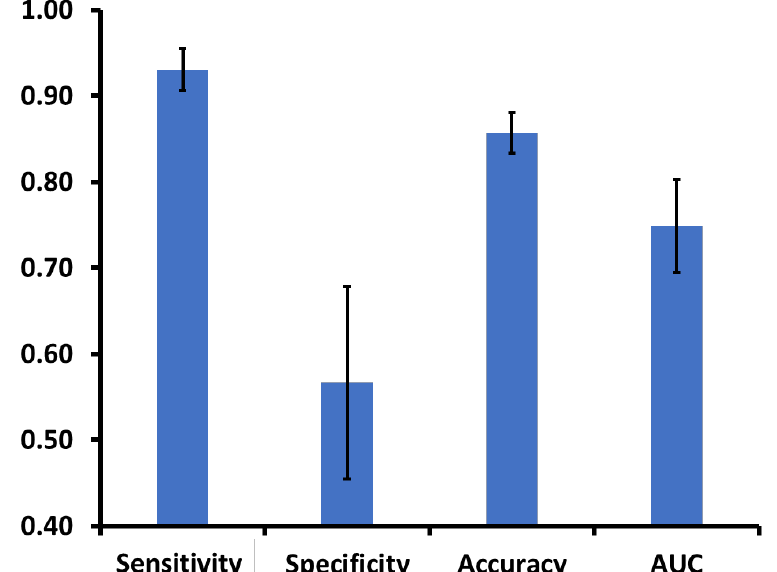
Figure 4. The classifier (decision tree) distinguishes older adults with cognitive frailty (PR-Cog-) from the rest of the aging groups. The classifier includes sensor-derived parameters and has an area under the curve greater than 0.75 on average.